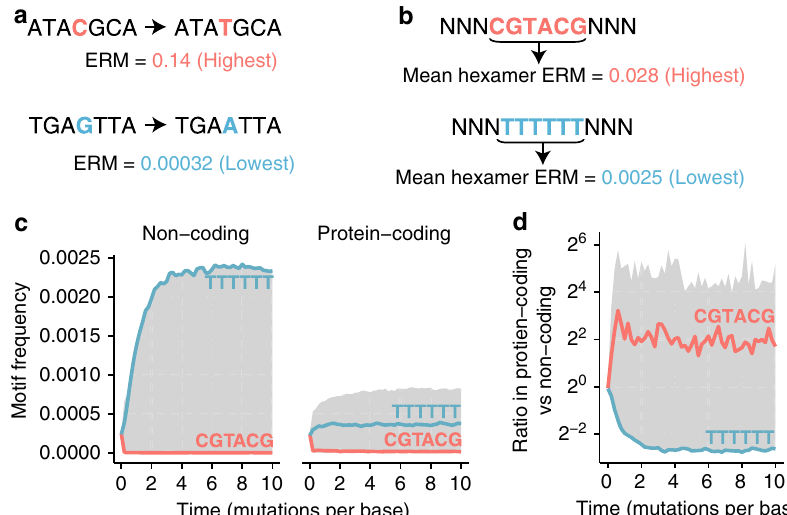
Fig. 1 Mutational bias and protein-level selection shape motif evolution. a The highest (red)/lowest (blue) estimated relative mutation (ERM) rates based on 7-mer contexts as reported by Carlson et al. 32 . b The most (red)/least (blue) mutable hexamers based on the mean ERM rates over all possible single nucleotide changes and fl anking sequence contexts. c Simulations initialized on a genome of random sequence were used to model the effects of protein-coding constraint and mutability on the evolution of motif frequencies ( y axis) over time ( x axis, mutations introduced per base of sequence). The simulation was run under the following conditions: with the constraint of preserving amino acid identity (right panel) or without constraint (left panel). Motif frequencies are shown for the most (red)/least (blue) mutable hexamers. Gray band shows the range across all 4096 hexamers as it evolves over time. d The frequency ratio of motifs in simulations with versus without coding constraint (analogous to exon versus intron enrichment) rapidly increased/ decreased for the most (red)/least (blue) mutable